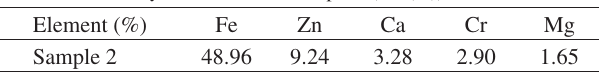
Figure 2. X ray di��ractio� (XRD) patter� o� sample 1. Table 3. Eleme�tary res�lts �o��d i� sample 2(wt. (%)).